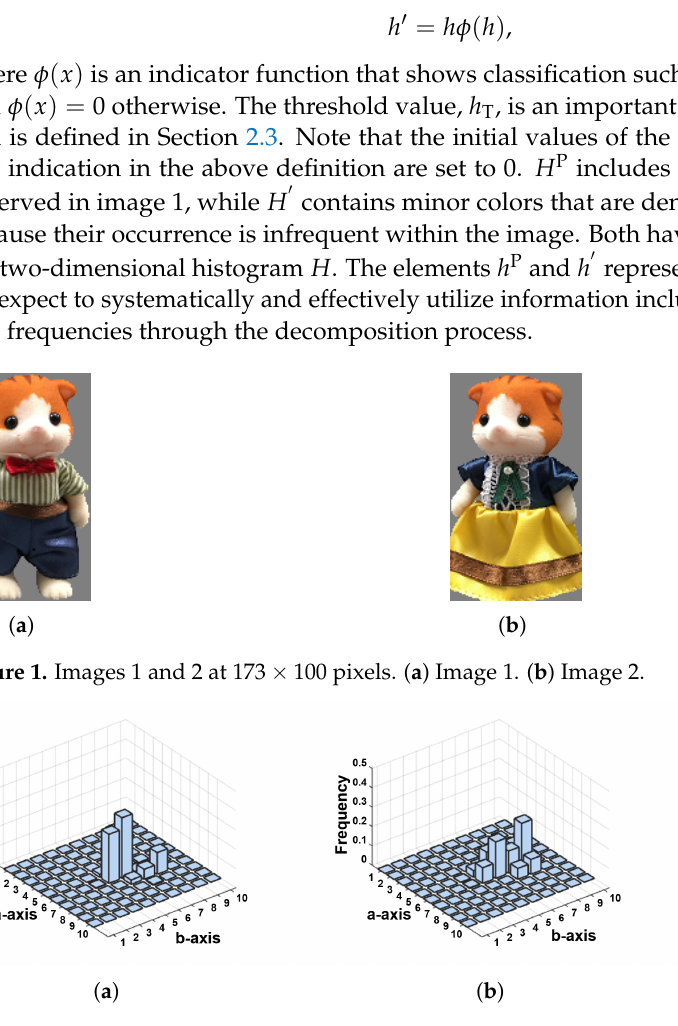
Figure 2. Original color histograms ( β 1 = 10, β 2 = 10). ( a ) H for image 1. ( b ) G for image